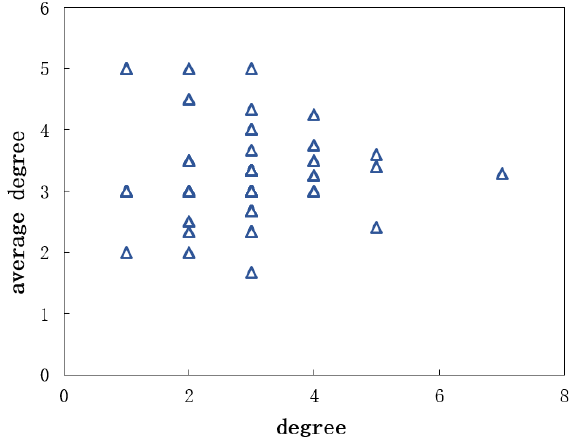
Figure 5. The relationship of the degrees of all the nodes and the average degree of their adjacent nodes.